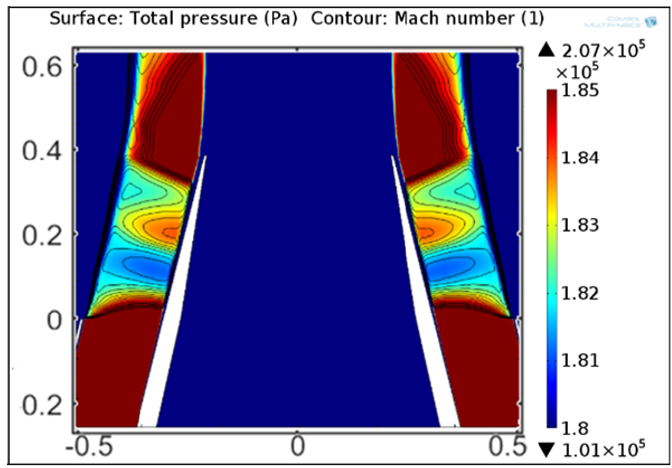
Figure 14. Pressure field in Condition 08. Mach > 1 contour lines in black are